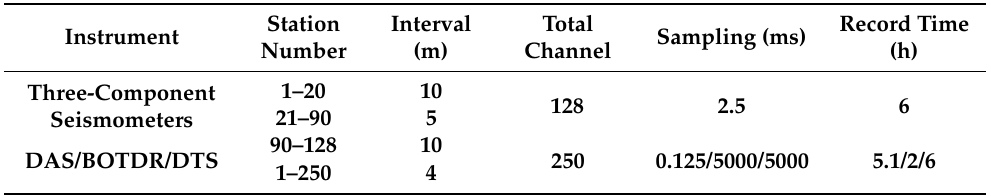
Table 1. Geometric parameters of the microtremor survey.